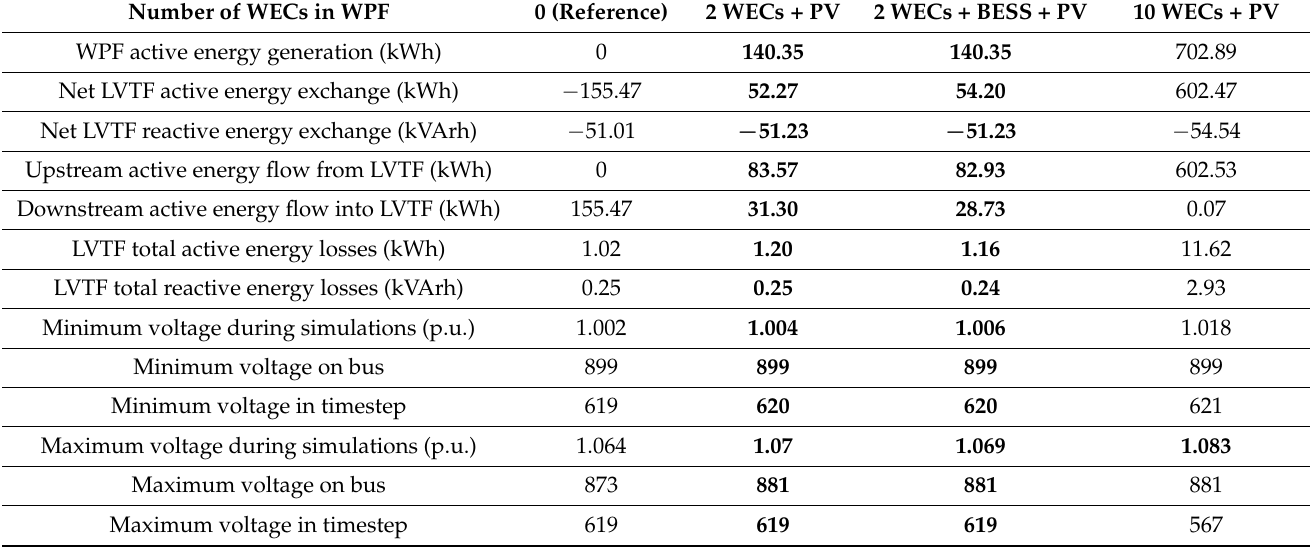
Table 9. Results of the daily operation simulation for case study